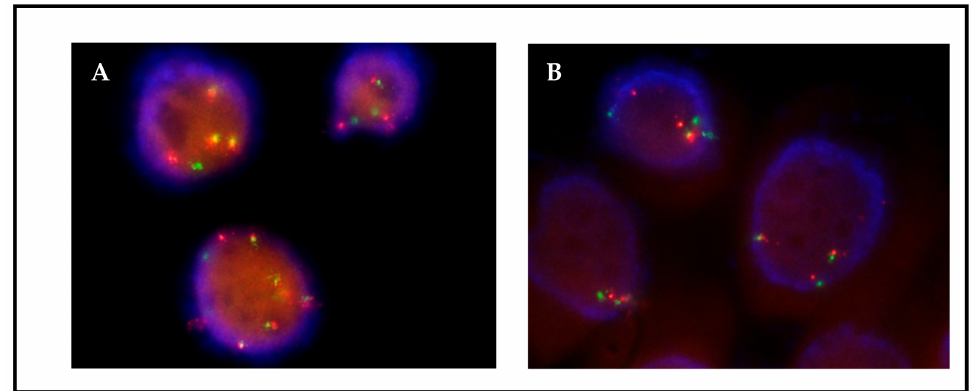
Figure 3. Patient 1, FISH ALK on passage 2 ( A ) and passage 13 ( B ). ALK translocation is maintained through culture. Translocation is observed as isolated green and orange signals.